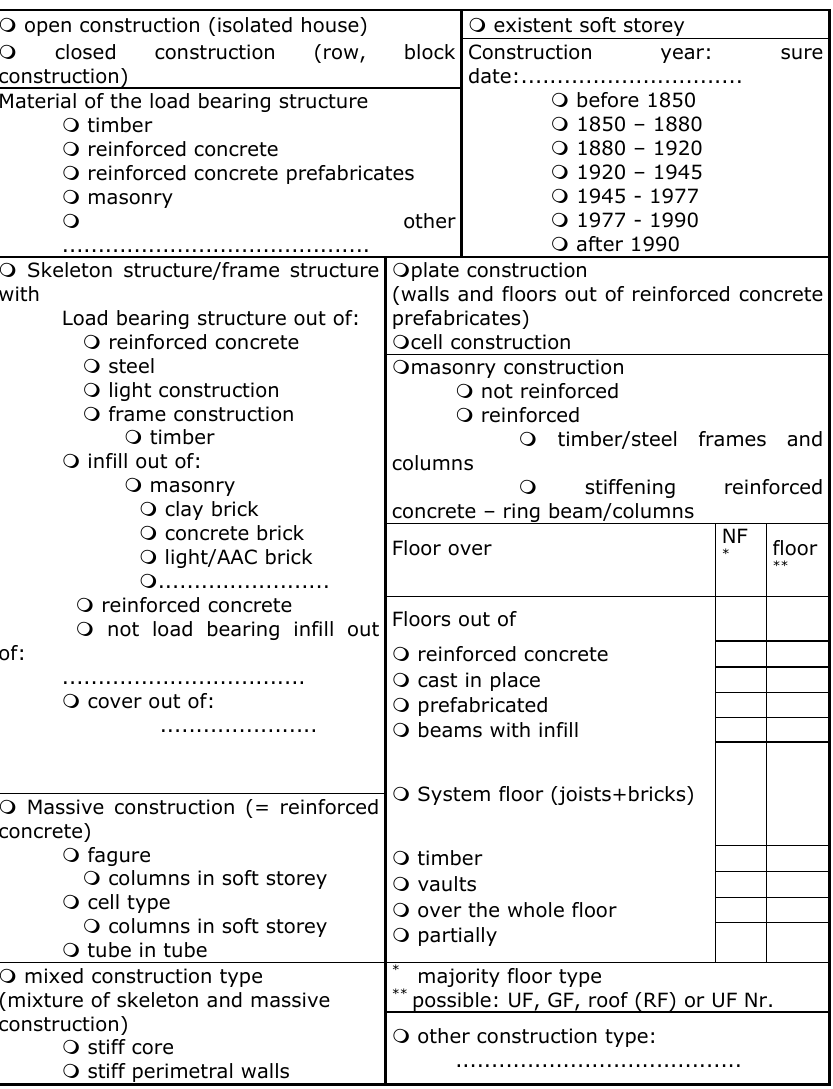
Table 1. Check list to establish the structure of the buildings in the surveyed area. Table 1: Check list to establish the structure of the buildings in the surveyed area Construction: